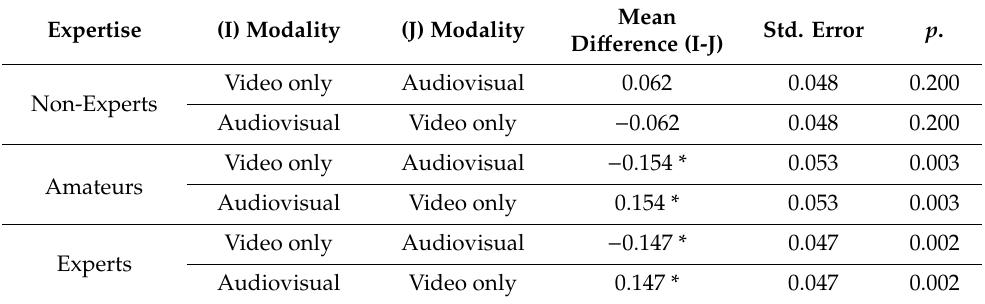
Table 5. Pairwise comparisons in gaze comprehensibility across expertise and presentation modality.